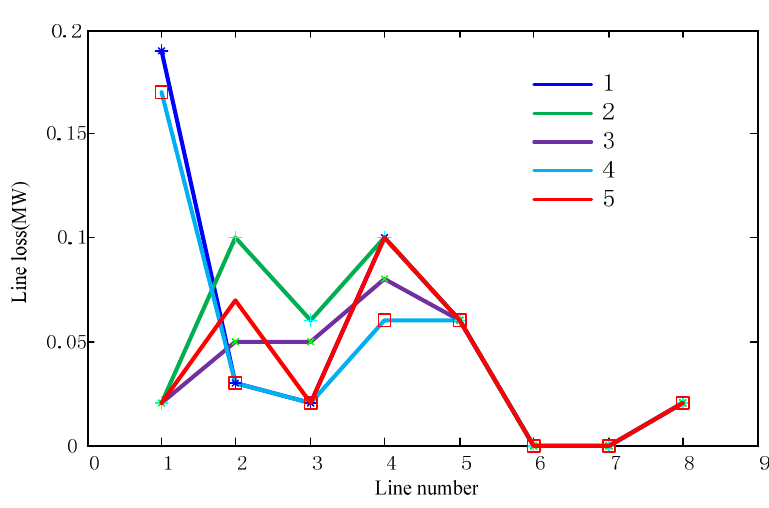
Figure 14. Branch losses performance of five